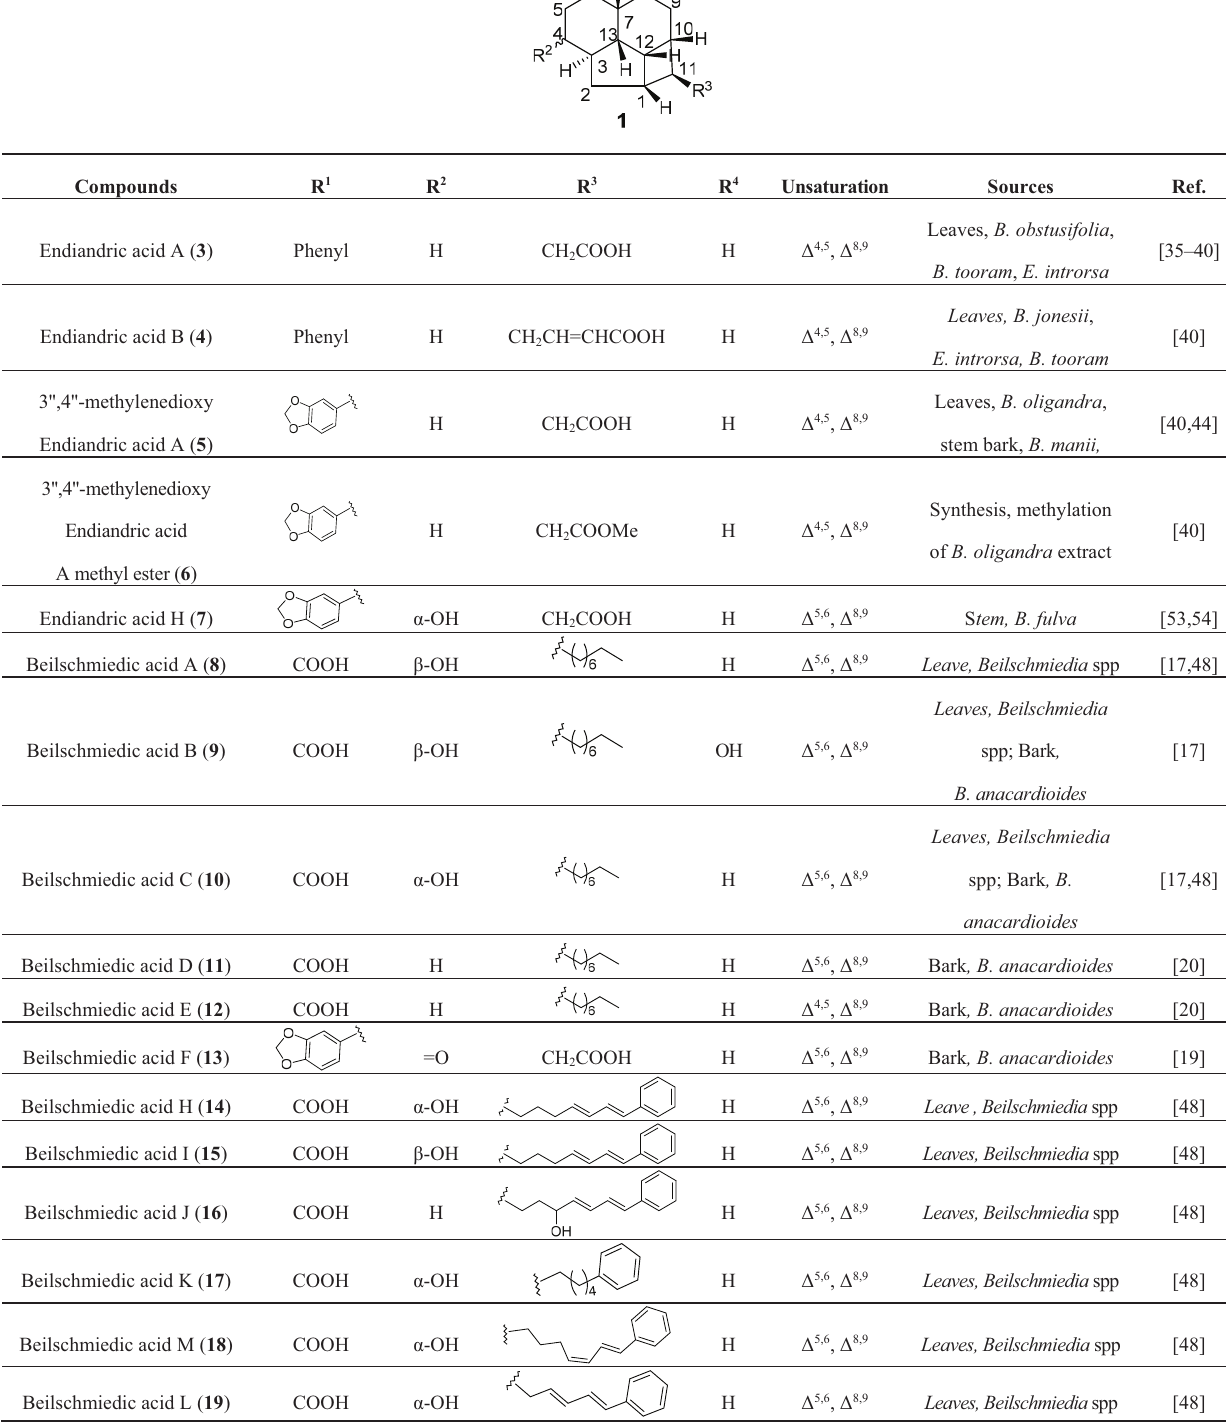
Table 1. Substitution pattern of endiandric acid derivatives with skeleton 1